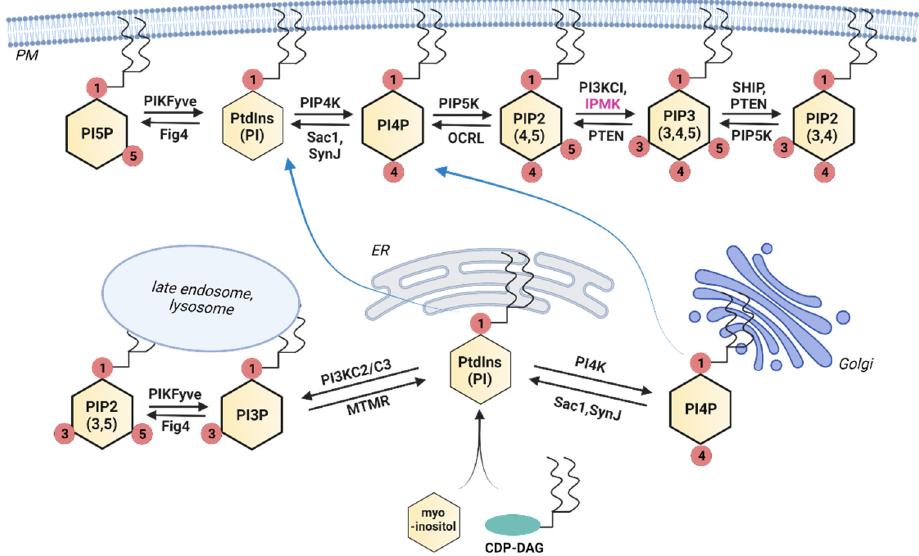
Figure 1. Biosynthesis of PtdInsPs in mammalian cells. The primary locations of the inositol lipids are shown along with the most common interconversions and converting enzymes. Blue arrows indicate the direction of lipid transport from one membrane compartment to another; black arrows indicate forward and reverse reactions. Note that PtdIns, the precursor to the PtdInsPs, is formed from myo-inositol and CDP-DAG at the ER (see text). ER: endoplasmic reticulum; CDP-DAG: cytidine diphosphate diacylglycerol; PIKFYVE: phosphoinositide kinase, FYVE-type zinc finger containing; FIG4: FIG4 phosphoinositide 5-phosphatase; PIP4K: phosphatidylinositol-5-phosphate 4-kinase; SAC1: SAC1 Like phosphatidylinositide phosphatase; SynJ: synaptojanin 1; PIP5K: phosphatidylinositol-4-phosphate 5-kinase; OCRL: OCRL inositol polyphosphate-5-phosphatase; PI3KC1: class I phosphatidylinositol 3-kinase; PTEN: phosphatase and tensin homolog; SHIP: SH2 domain-containing inositol 5 ′ -phosphatase 1; PI3KC2/C3: class 2/class 3 phosphoinositide 3-kinase; MTMR: myotubularin-related protein/phosphatidylinositol-3-phosphatase. Created with BioRender.com, accessed on 27 May